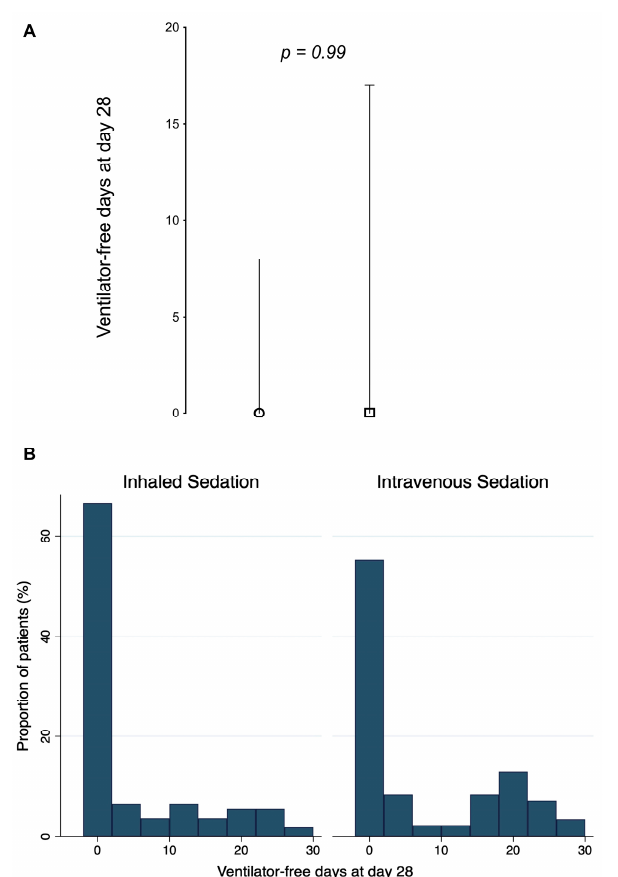
Figure 2. Primary outcome of ventilator-free days through day 28. ( A ) Median values (with interquartile ranges) in the patients who received inhaled sedation for at least 24 h (inhaled sedation group) and those who received intravenous sedation only (intravenous sedation group) through day 28. ( B ) Distribution of ventilator-free days through day 28 in both study groups. Table 2. Unadjusted analysis of ventilator-free days through day 28 using zero-inflated negative binomial